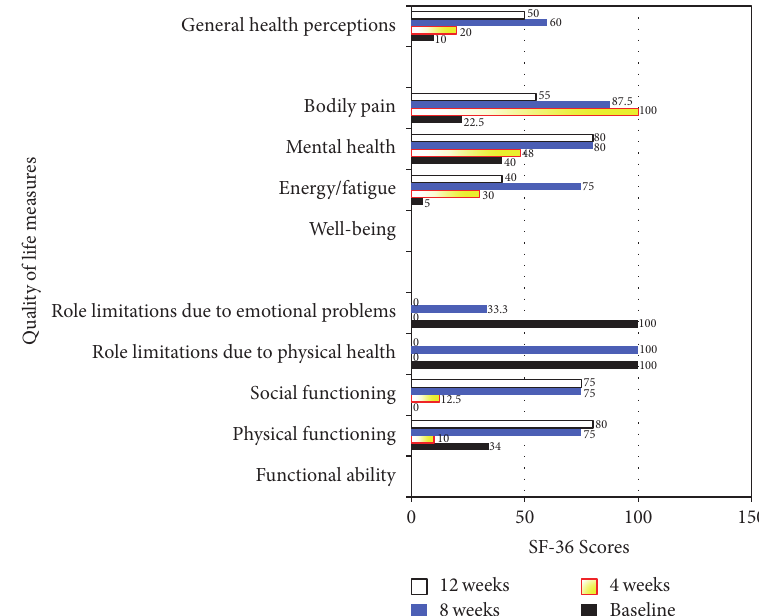
Figure 3: SF-36 scores in quality of life measures, before procedure and up to 12 weeks after procedure. A 50% improvement from baseline scores was used as an indicator of treatment